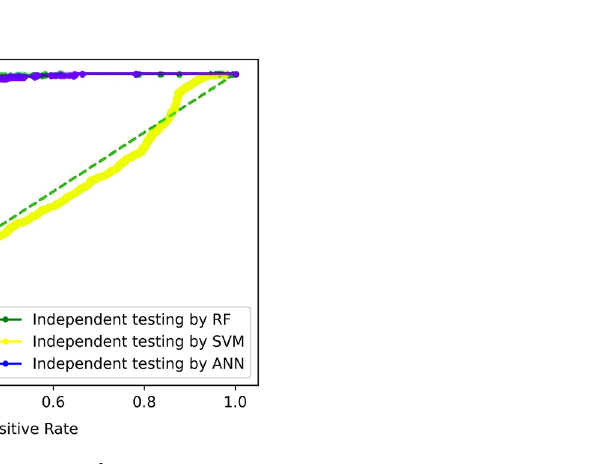
Figure 8. Independent testing comparison of ROC